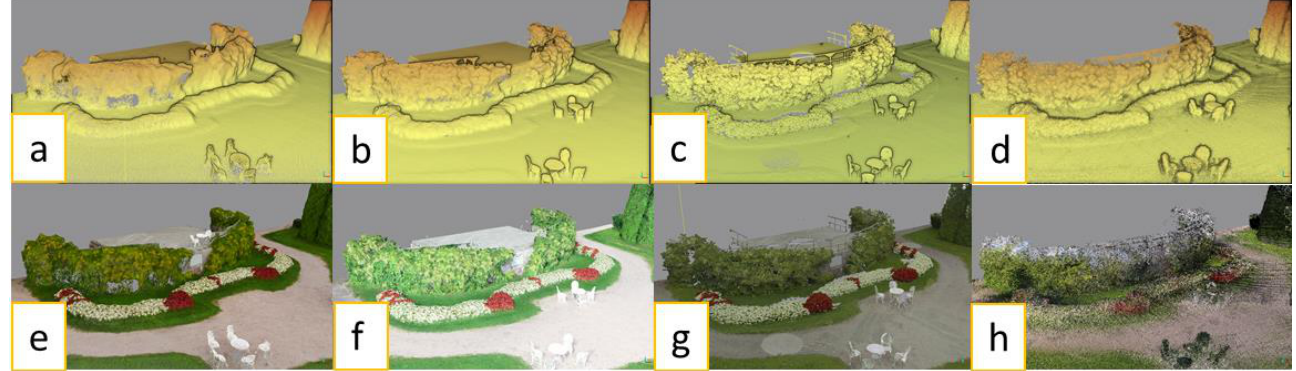
Figure 12. Comparisons of point clouds for perennials, lawns, perennial vines, and semipermeable surfaces: grass stones, and permeable pavements: sand surfaces. In the top row, the point clouds are colored with the height ramp, and in the bottom row with RGB colorization.